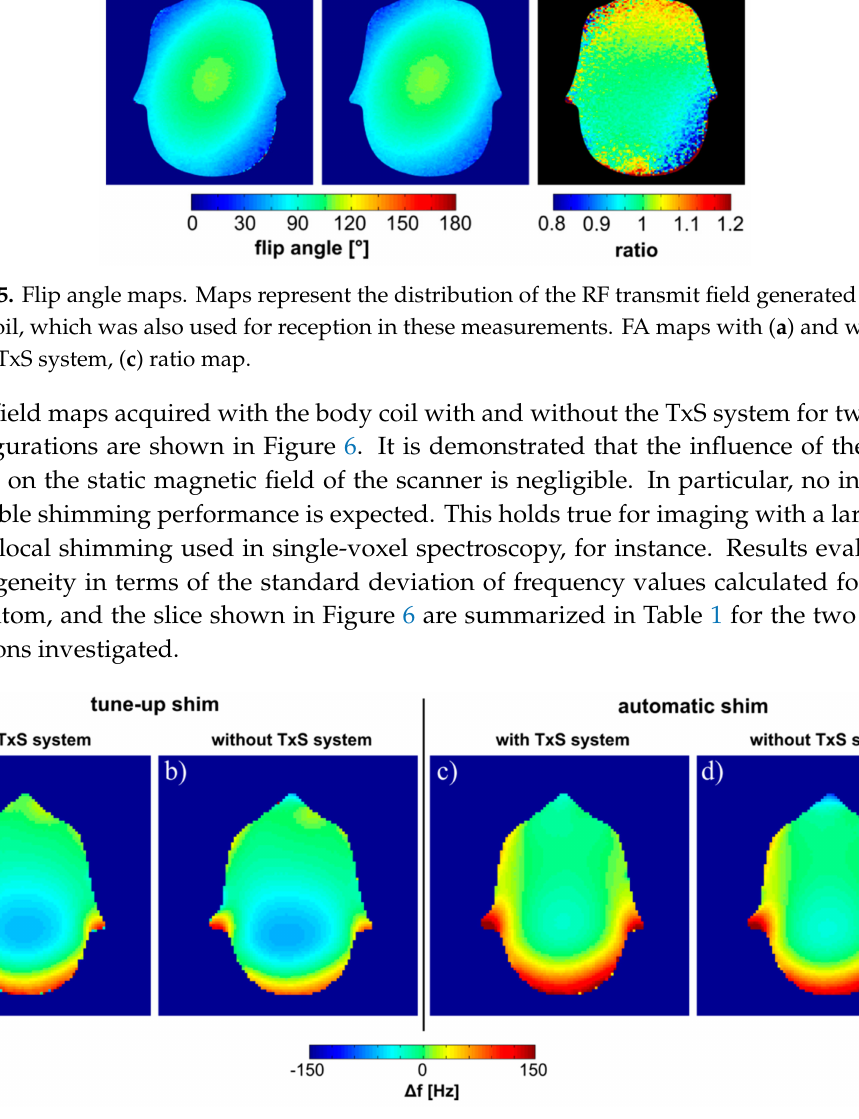
Figure 6. Influence of the liquid drive on B 0 . Field maps with and without the TxS system for the tune-up shim ( a , b ) and after applying the automatic shimming procedure of the scanner ( c , d ). Table 1. B 0 homogeneity. Standard deviation values of the frequency, measured with and without the TxS system for tune-up shim and automatic shim. Data were evaluated either for the entire phantom or only for the slice shown in Figure